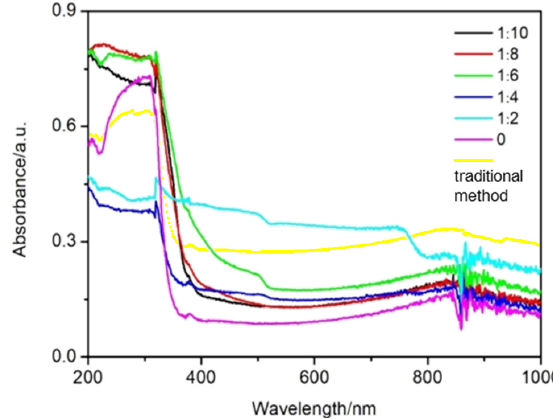
Figure 3. UV-vis absorbance spectrum of the CH 3 NH 3 PbI 3 /TiO 2 composite thin films prepared from PbO-TiO 2 thin film with different ratios of